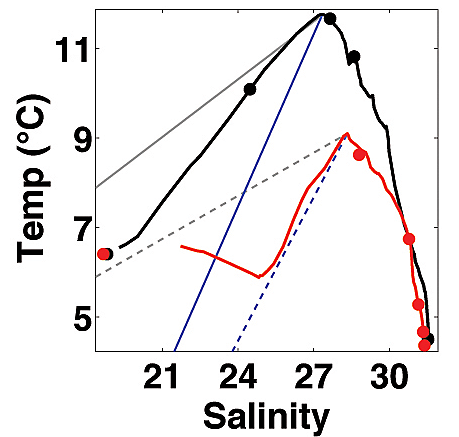
Fig. 7. Temperature ( ◦ C)–salinity diagram for September 2011 (black) and September 2012 (red) profiles in Icy Bay (Fig. 1). Traces are from CTD downcasts, and dots are the measurements made at the depth Niskin bottles were fired during upcasts. The solid and dashed gray lines are mixing lines between source waters estimated from Fig. 6, and freshwater at 0 ◦ C, with solid and dashed lines marking 2011 and 2012 data, respectively. The solid and dashed blue lines are mixing lines that describe ice melting in seawater, following Walters et al. (1988), with the 2011 and 2012 source wa- ter characteristics, respectively.